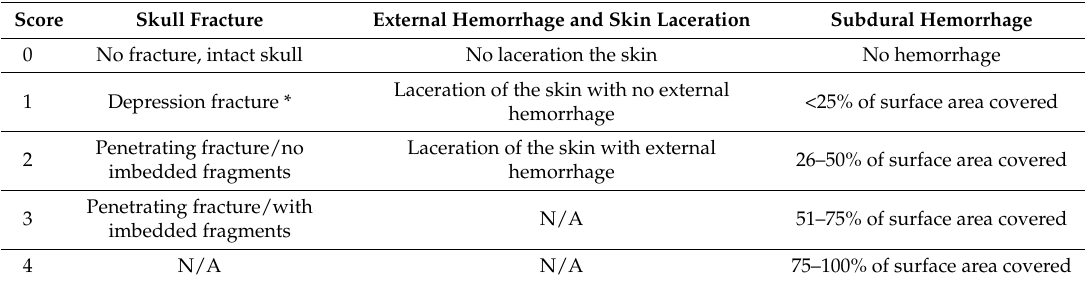
Table 3. Macroscopic scoring criteria for trauma, fracture and hemorrhage, modified from [19,22]. Score Skull Fracture External Hemorrhage and Skin Laceration Subdural Hemorrhage 0 No fracture, intact skull No laceration the skin No hemorrhage Laceration of the skin with no external <25% of surface area covered 1 Depression fracture * hemorrhage Penetrating fracture/no Laceration of the skin with external 26–50% of surface area 2 imbedded fragments hemorrhage